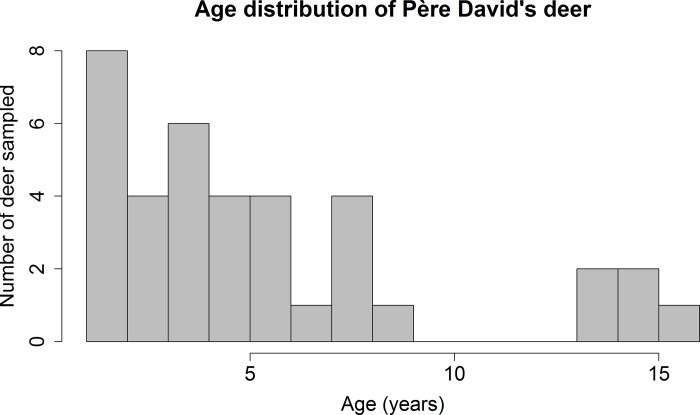
Age distribution of the 37 (23 females, 13 males, 1 unrecorded) sampled Père David’s deer.There were no individuals from 9 to13 year old. Reproductive status was not recorded but pregnant individuals were in their third trimester of gestation, by The Wilds records and based on seasonality of breeding in this species.